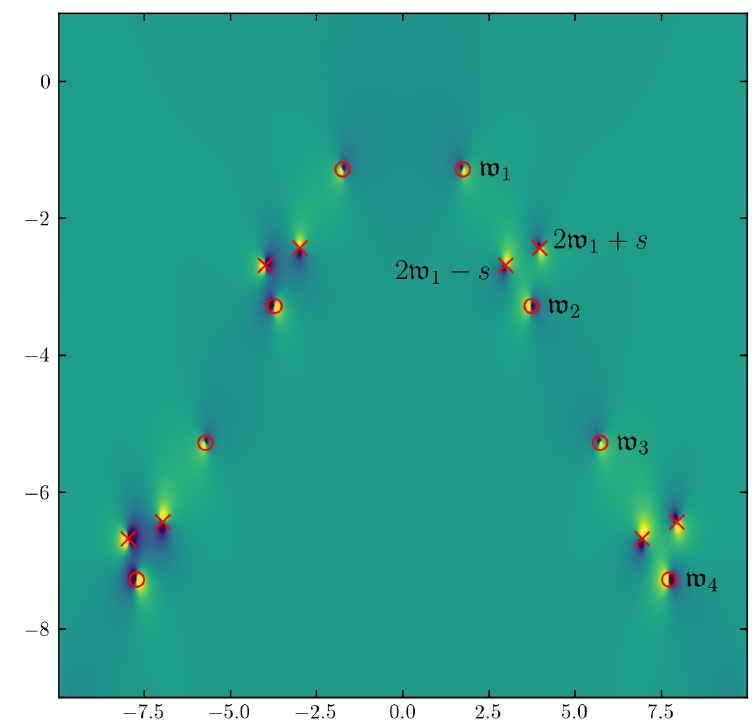
Figure 3 . The retarded three-point function, Re r 3 ( p 1 , p 2 ) , shown at zero spatial momentum p i = p i = 0 in the complex plane of the total driving frequency, p = p 0 1 2 frequency difference s ≡ p 0 − p 0 (here, for illustration s = 1 / 2 + i/ 8 ). All singularities shown are 1 2 simple poles, each corresponding to a single leg of the three-point function taking a QNM frequency, denoted by w i . Circles correspond to resonant excitations of QNMs through bulk interactions, while crosses correspond to direct driving of QNMs by the external momenta. By tuning s the crosses can be made to collide with other singularities, this is demonstrated in figure